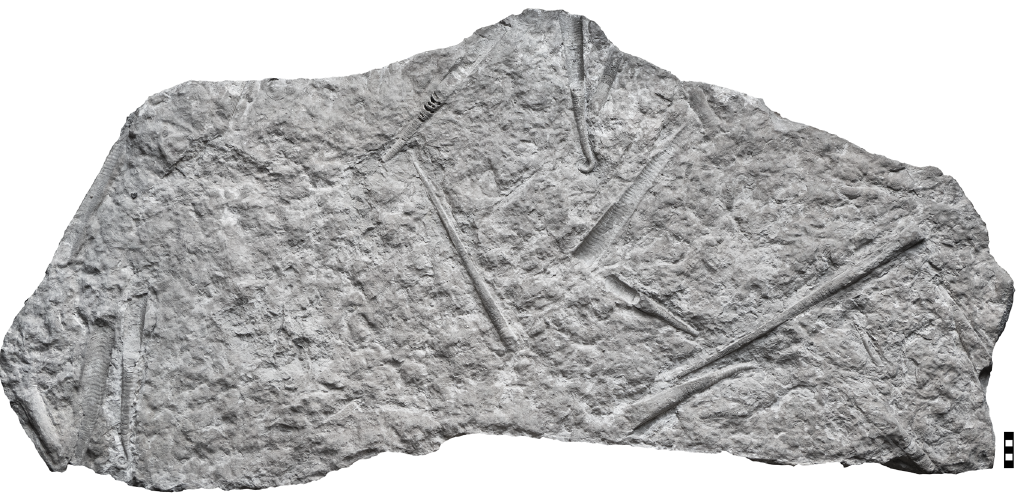
Fig. 1. Large slab of the Upper Grey Orthoceratite Limestone (late Darriwilian, Middle Ordovician) with scattered conchs of lituitid and orthoceratid cephalopods, sample MB.C.30490 from the Island of Öland (Sweden). Scale bar units = 10